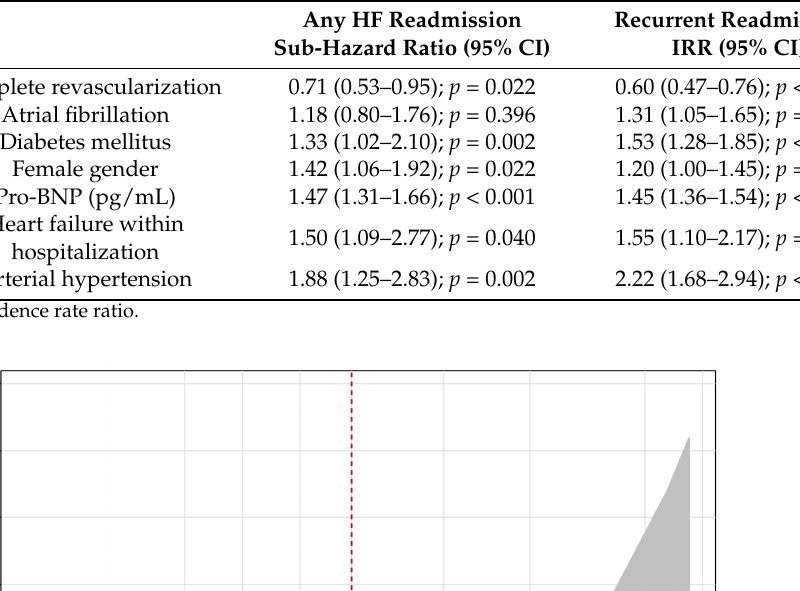
Table 3. Independent predictors of heart failure readmission.